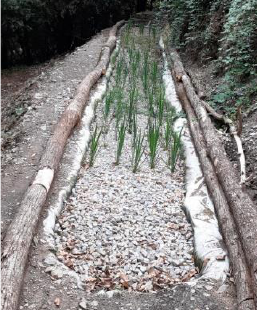
Figure 13. ( Left ) Artificial marshlands formed by shallow ponds with gravel and aquatic vegetation (70% Phragmites australis and 30% Iris pseudacorus ). ( Right ) Schematic draft with permission from [40]. Copyright 2006 by the Water Environment Research Seizing Water Rain